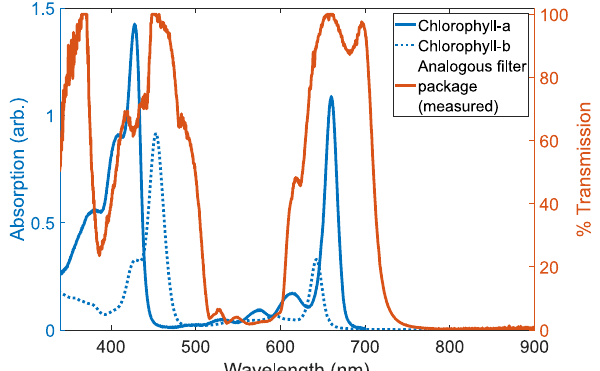
Figure 4. Chlorophyll Filtering. The absorption profile of Chlorophyll-a and Chlorophyll-b in diethyl ether 54,55 is emulated by the combination of a 45 ◦ magenta dichroic filter and a 700 nm shortpass filter. The filter package effectively cuts out the green light band from 500–600 nm and the near-IR above 700 nm. It is important to note that the dip in measured transmission percentage between 370–450 nm is not due to filtering by the filter package, but rather a limitation of the light sources used to measure the transmission. It is reasonable to expect the actual transmission percentage to be near 100%, based on the transmission specifications of the components